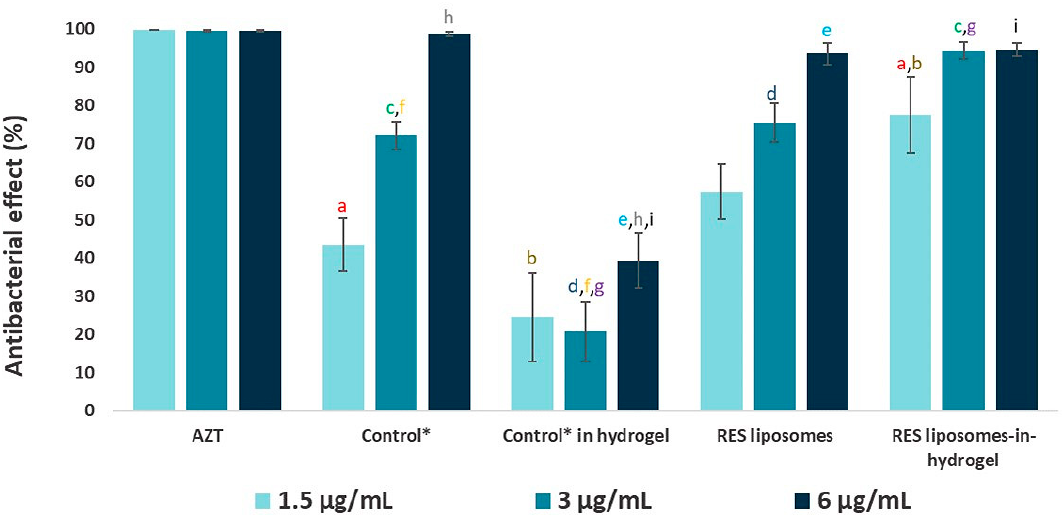
Figure 3. E ff ect of RES formulations on C. trachomatis in vitro ( n = 4). The values are based on images presented in Figure 2. Number of inclusions for the treated and the non-treated cells were compared. * RES in propylene glycol, a , b , c p < 0.05, d , e , f p < 0.005, g , h , i p < 0.001.